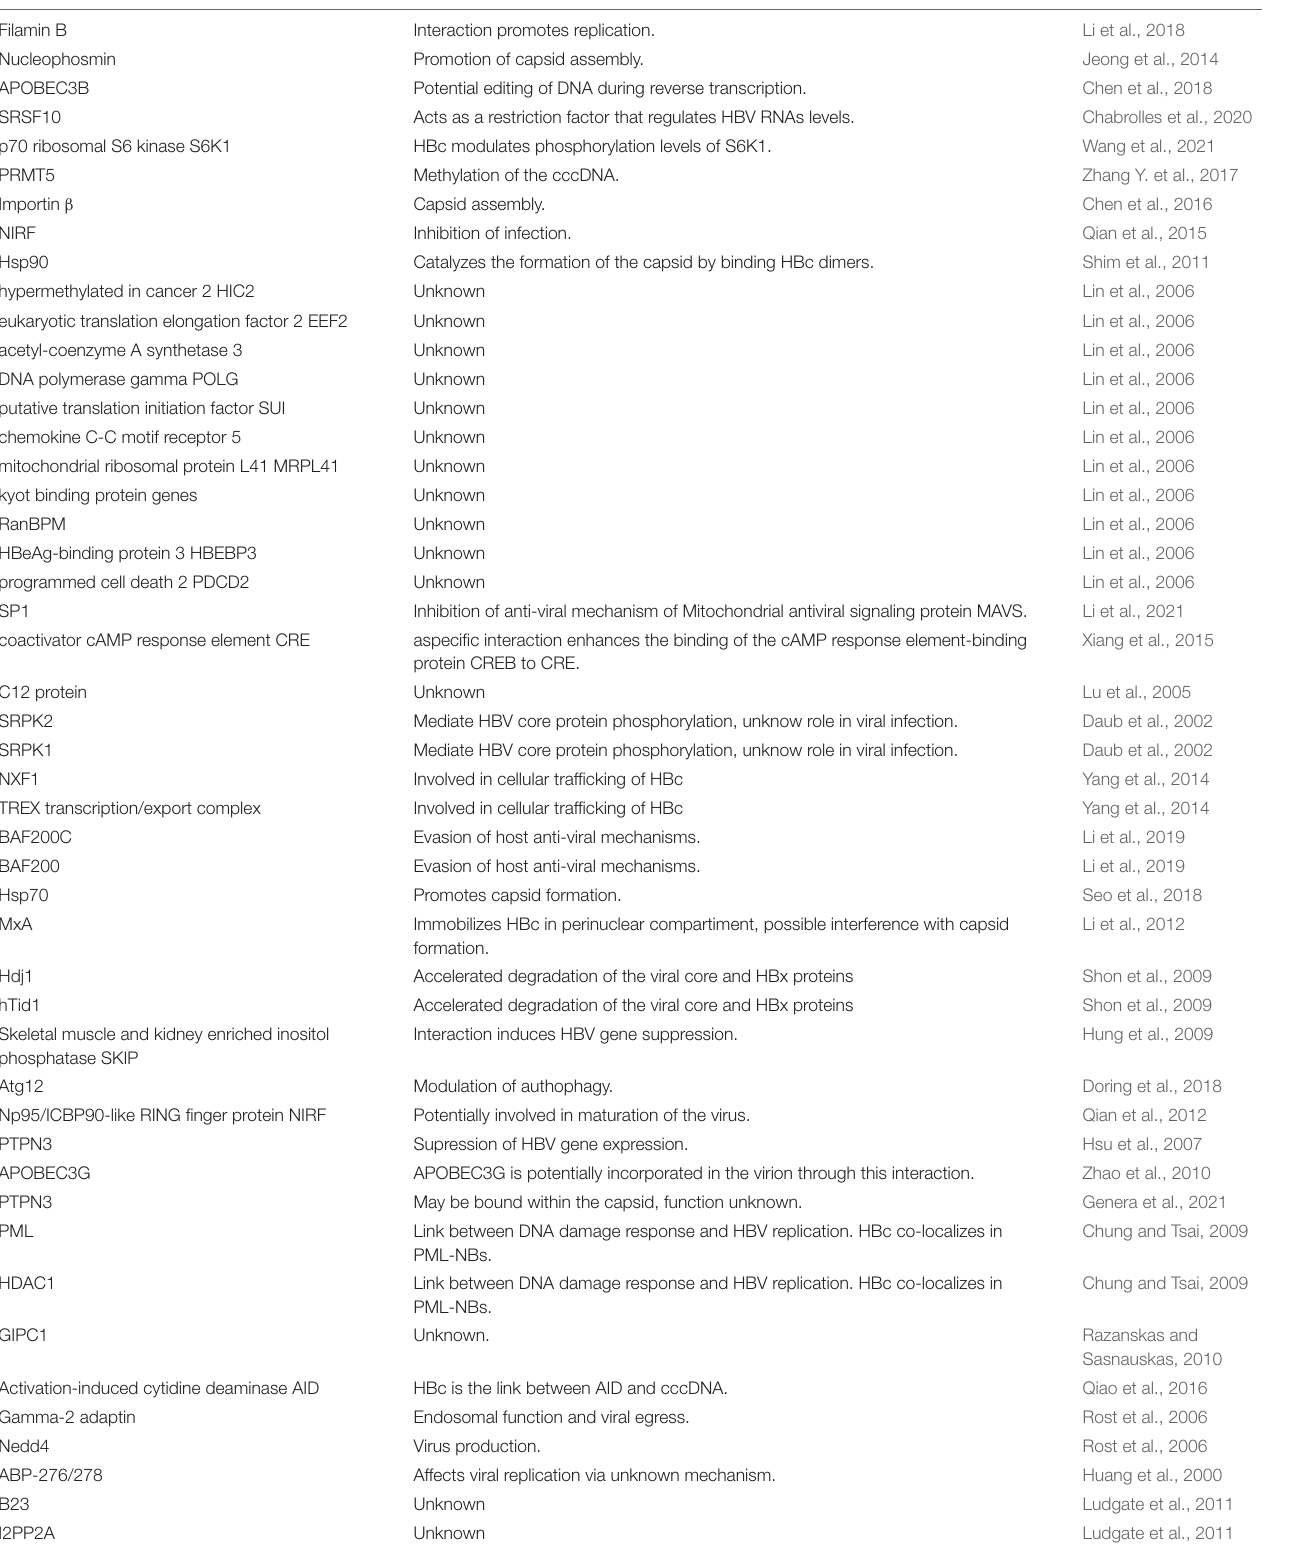
TABLE 3 | HBc interacting proteins listed together with the cellular processes or pathways in which they are involved. Protein interaction